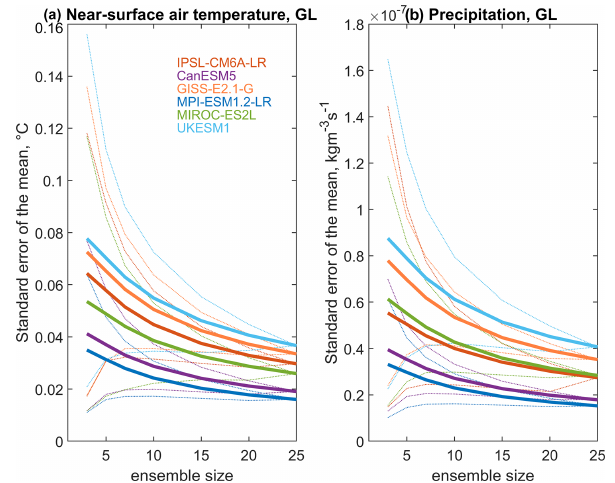
Figure 12. Ensemble size and spread. Standard error of the mean of anomalies calculated for different ensemble sizes across the differ- ent models for two key surface variables: global-mean near-surface air temperature (a) and global-mean precipitation (b) . Shown are means (thick line) and 5–95th percentile ranges (see Sect.